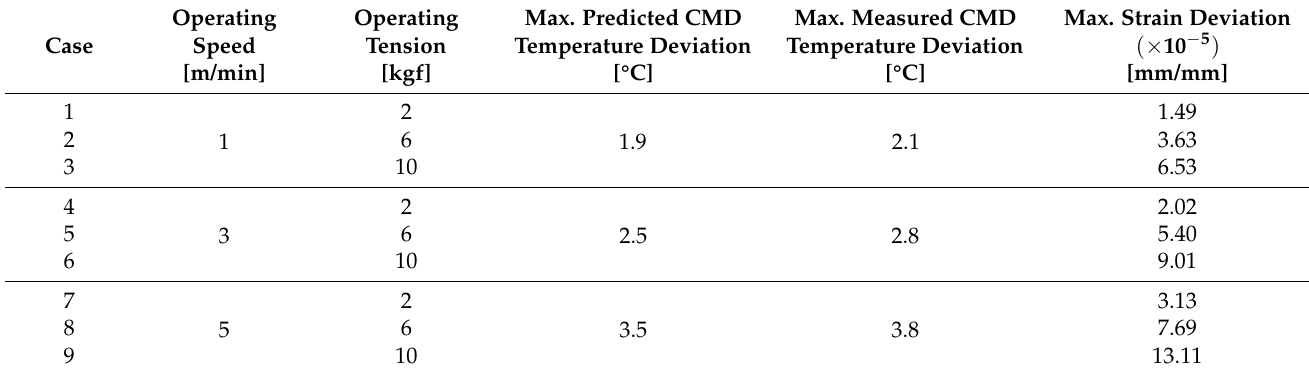
Figure 4. CFD mesh model: ( a ) roll-to-roll dryer system; ( b ) dryer cross-section; ( c ) solid model of the moving web. Table 3. Results of measured web temperature and estimated strain distribution for Cases